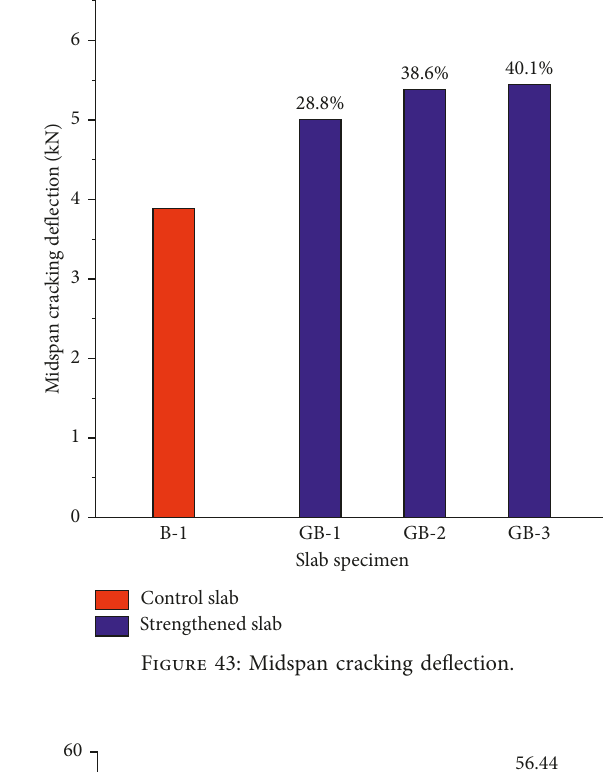
Figure 41: Ultimate load.